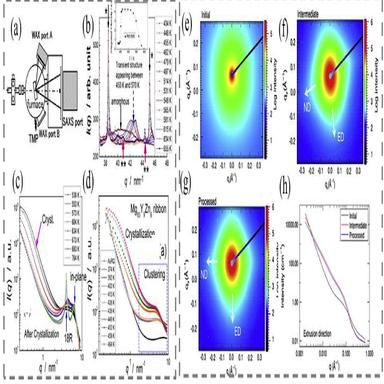
The SR-SAXS pattern and intensity profiles in Mg alloys: (a) the Schematic of SR-SAXS; (b) change of Bragg peaks; (c, d) change of small-angle scattering ; (e–g) 2D maps of the small angle X-ray scattering intensity. (h) SR-SAXS intensity profiles .